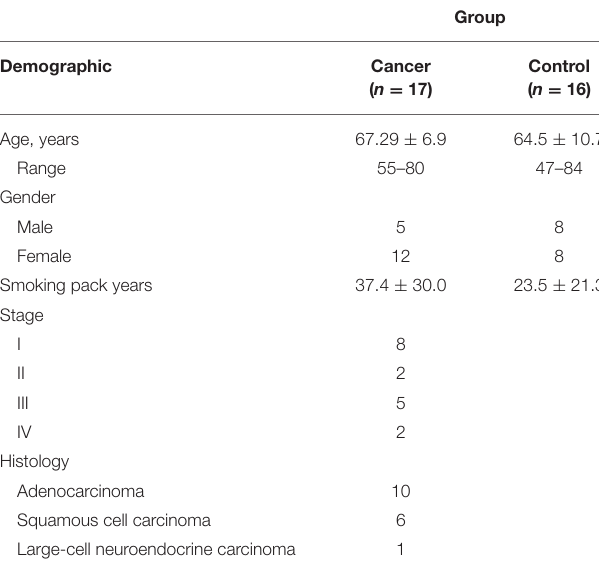
TABLE 1 | Patient demographics and clinical